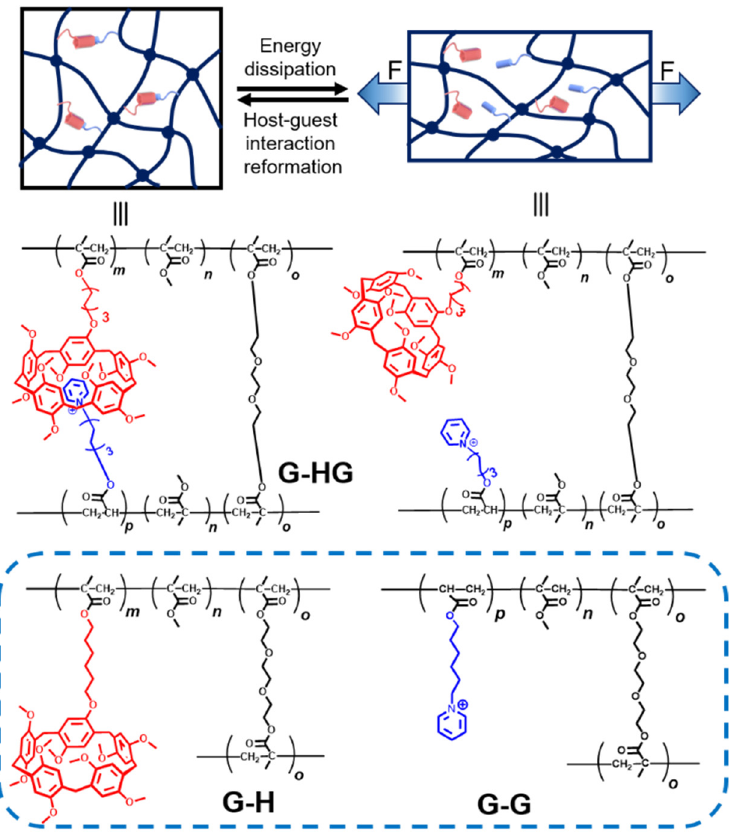
Figure 1. The energy dissipation mechanism of the polymer gel network bearing pillar[5]arene-based host–guest interactions and the chemical structures of G-HG , G-H , and G-G polymer gels.